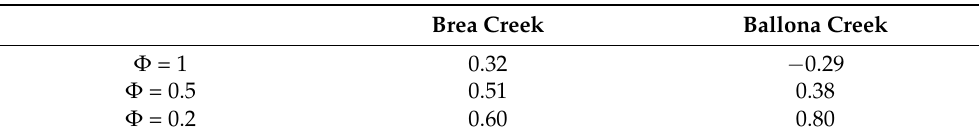
Table 4. NSE coefficients for simulated hydrographs of the December 2010 event in the Brea Creek and Ballona Creek watersheds.